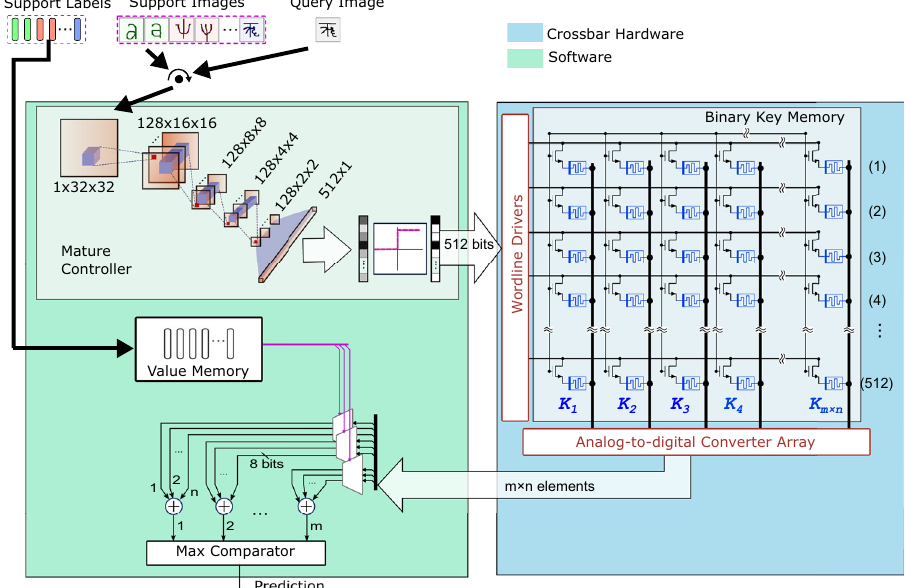
Fig. 4 The MANN architecture with the binary key memory using analog in-memory computations. The architecture is simpli fi ed for ef fi cient few-shot inference: (1) The transformed HD support vectors are stored in a memristive crossbar array as the binary key memory; the query vectors are binarized too. (2) The cosine similarity ( α ) between the input query vectors and the support vectors is computed through in-memory dot products in the crossbar using Eq. (10). (3) To further simplify the inference pipeline, the normalization of the attention vectors and the regular absolute sharpening function are bypassed. The accumulation of similarity responses belonging to the same support label in the value memory and fi nding the class with maximum accumulated response are implemented in software. The binary query/support vectors have 512 dimensions. m and n stand for “ way ” and “ shot ” of the illustrated problem respectively. A similar architecture with the bipolar key memory is shown in Supplementary Fig.